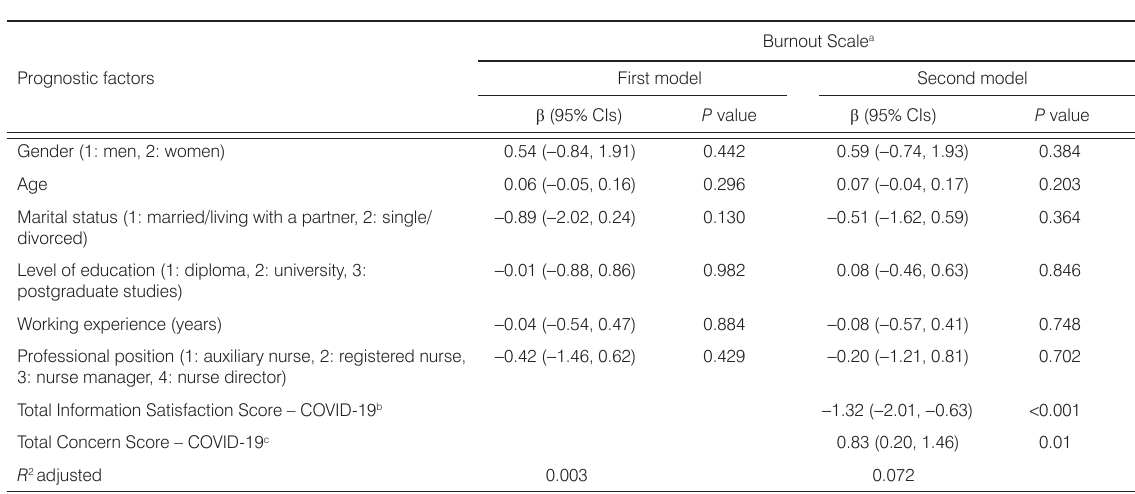
Table 5. Hierarchical multiple linear regression of the Burnout Scale as an outcome with the characteristics of Information Satisfaction and Concern for COVID-19 in the study participants as independent variables.